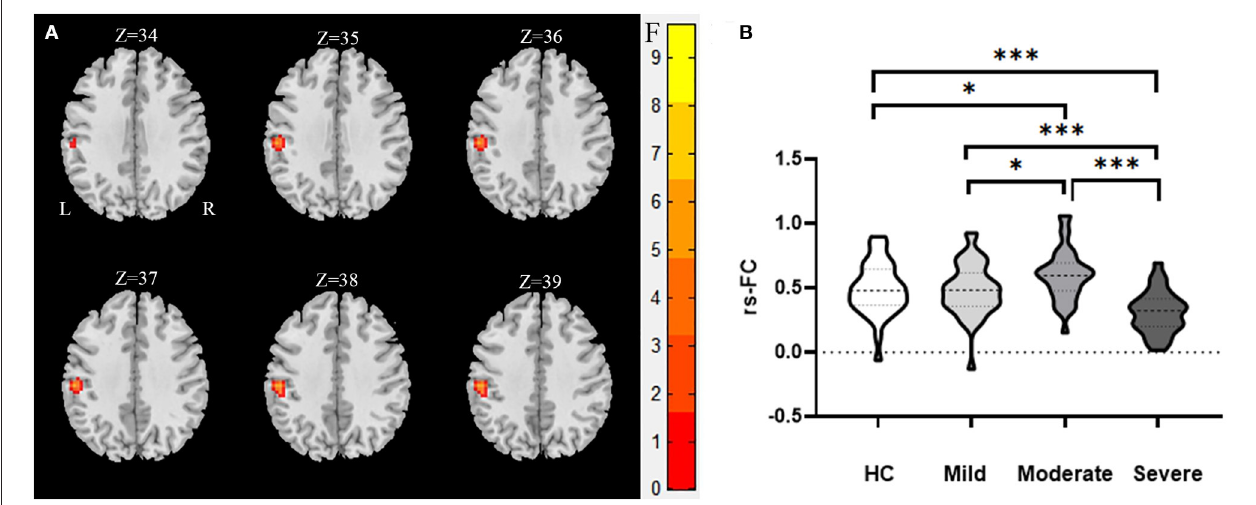
FIGURE 3 | The abnormal functional connectivity between the left superior parietal gyrus and the left parietal inferior gyrus of the WMHs in MNI space. (A) Significant abnormal functional connectivities were observed between the left superior parietal gyrus and the left parietal inferior gyrus [34, 35, 36, 37, 38, 39 in (A) are the coordinates of Z-axis in Montreal Neurological Institute space, and the unit of coordinate system is millimeter]. (B) Mean values of the abnormal functional connectivities in these groups. ***Significant at 0.001 level and *significant at 0.05 level (2-tailed).